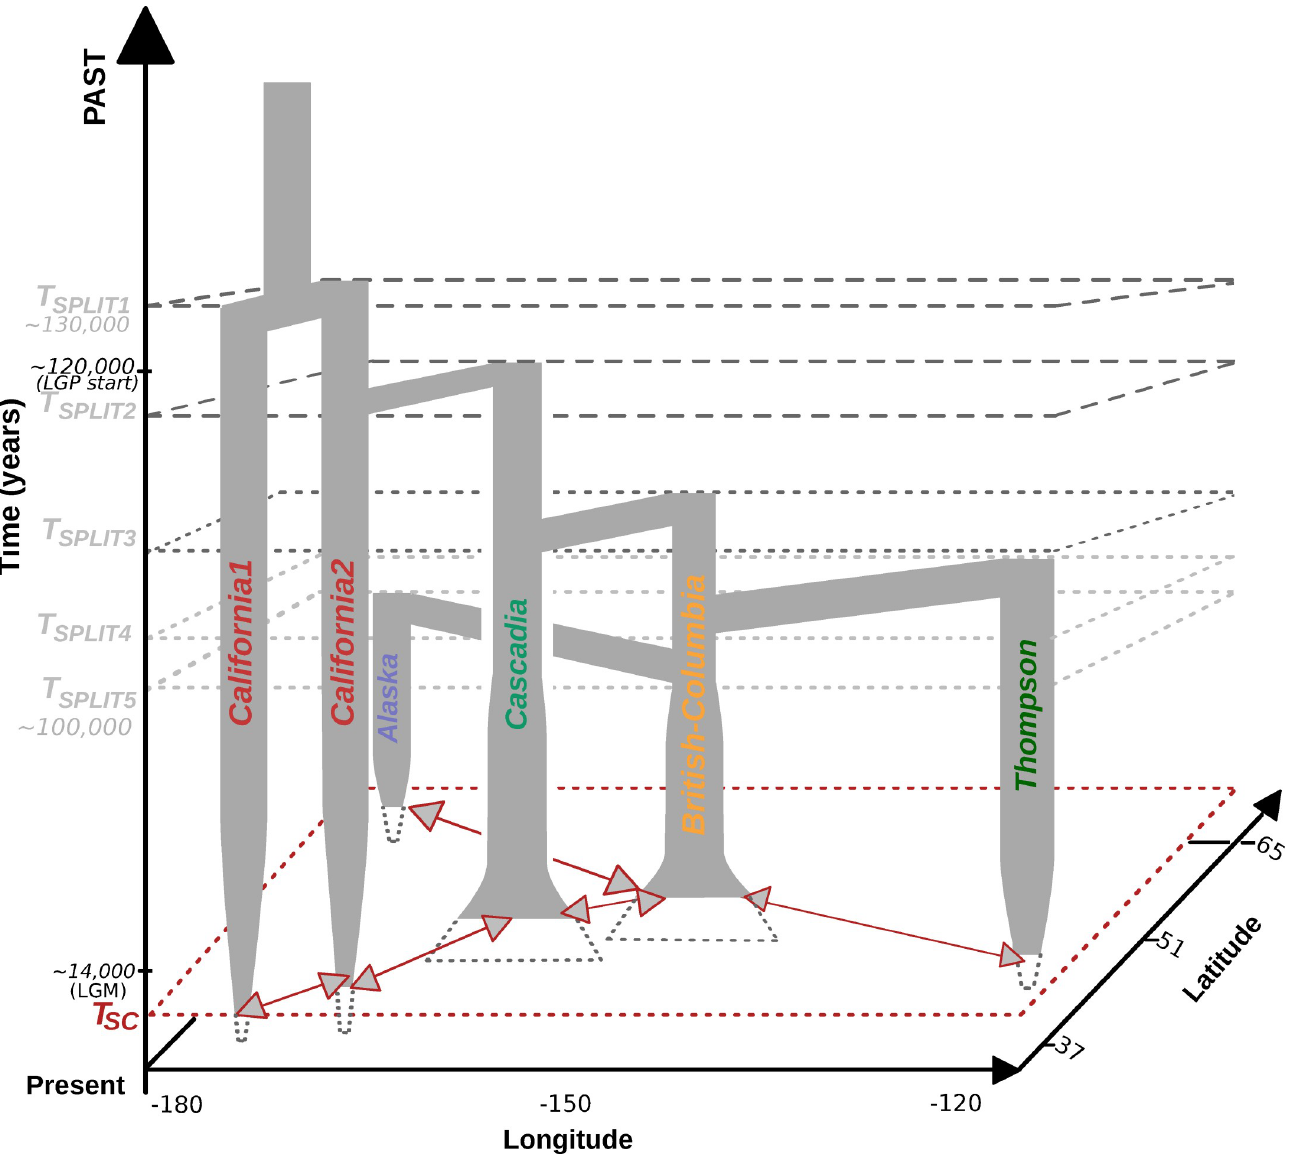
Fig 7. Simplified spatio temporal representation of the coho salmon demographic history based on @ a @ i and Fastsimcoal results. Each bar represents a population branch. the width of the branch is not proportional to the population effective size and do not account for historical population size changes. The split time are not to scale and geographic positions are approximate. Tsc = Time of secondary contact. Red arrows represents major gene flow events between neighboring populations. Details about gene flow event can be found in S5 Table and S7 Table. LGP = approximate start time of the Last Glacial Period [96]. LGM = Last Glacial Maxima Beringia was unglaciated during most of the pleistocene [97]. See results for details of the grouping.